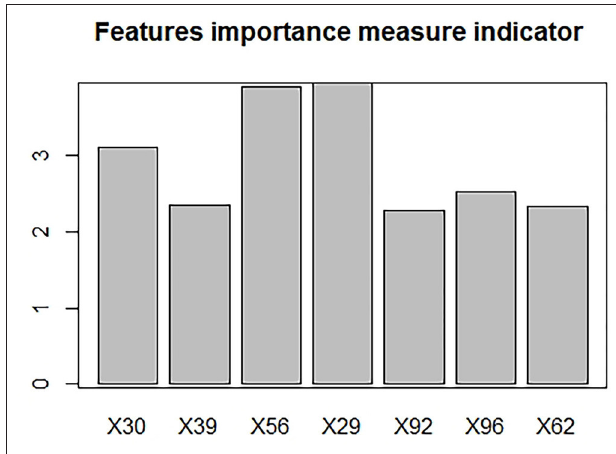
FIGURE 4 | The features importance measurement